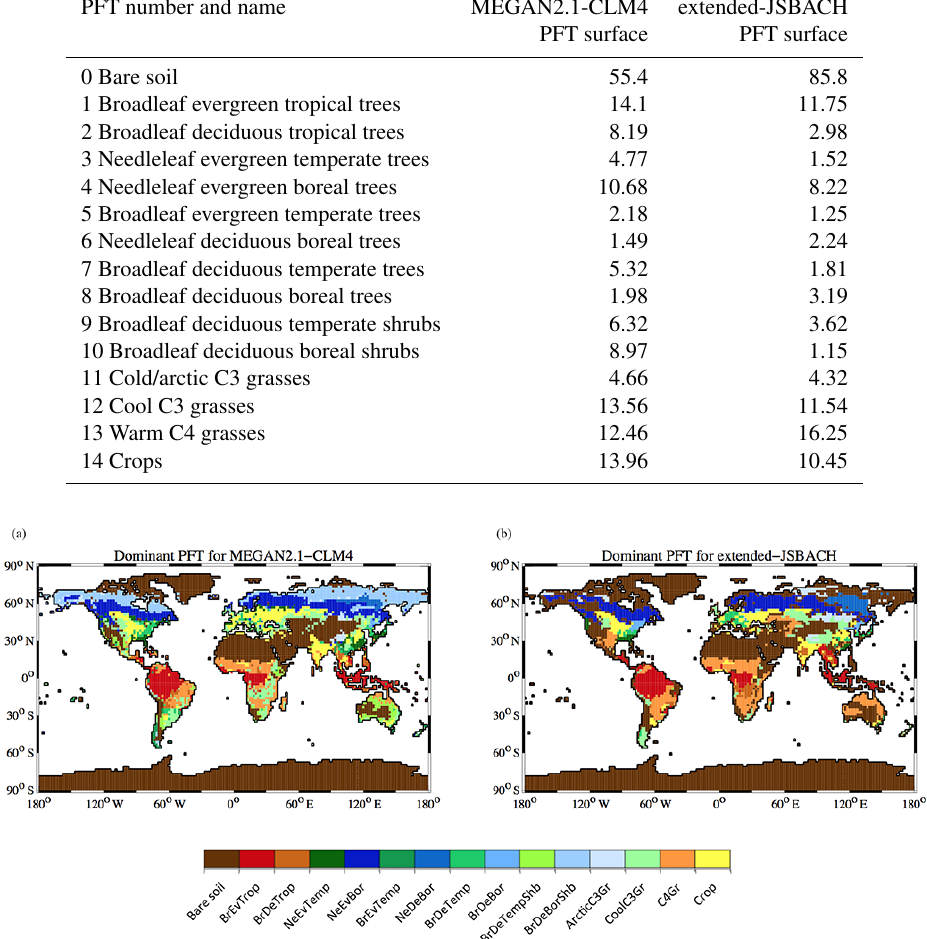
Table 6. Continental surface areas covered by the MEGAN2.1-CLM4 PFTs and the extended-JSBACH PFTs (10 12 m 2 ). PFT number and name